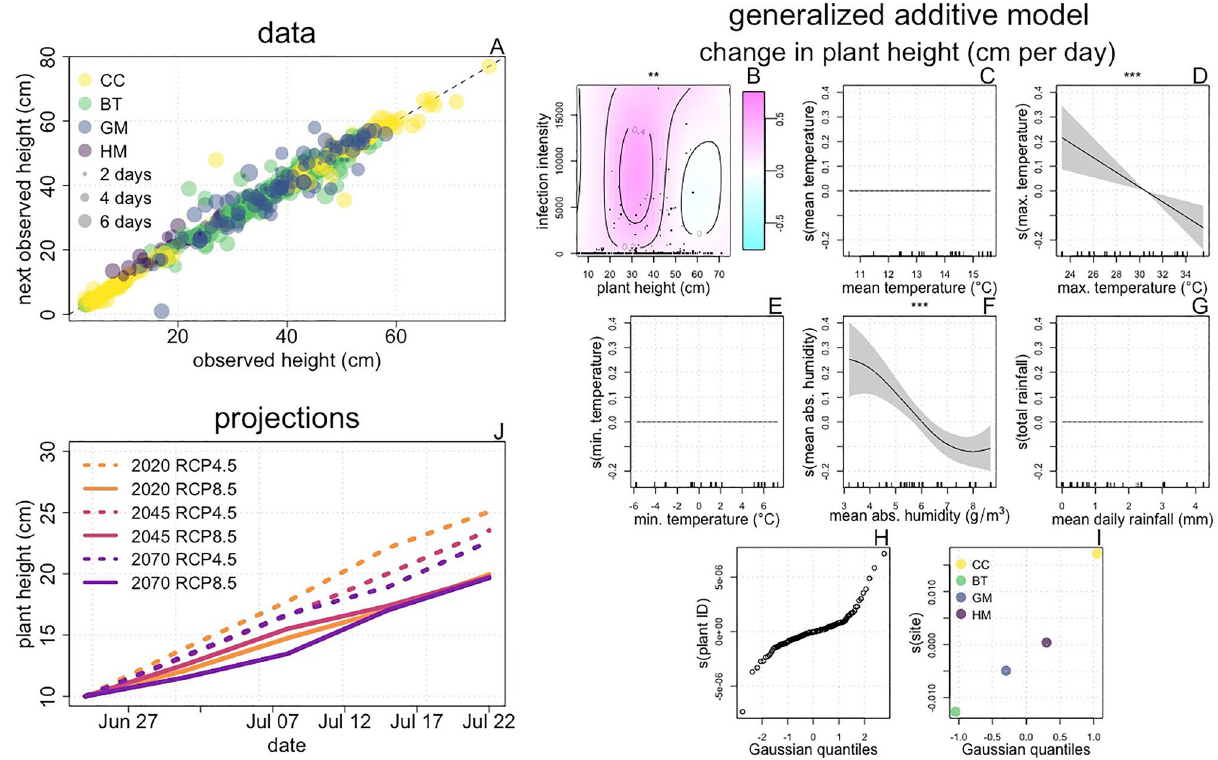
Figure 4. The joint effects of climate change and infection on L. lewisii growth. Data: We made a total of 596 observations of plant height from 175 focal plants (panel A ). Points show individual observations with color indicating site and size indicating elapsed time. Unsurprisingly, we observed both increases and decreases in plant height as plant condition changed over the course of the observation period. The dashed line illustrates y = x to show where increases and decreases occurred. Generalized additive model: We fit a GAM to this data, using change in plant height per day as the response variable, and smooth terms for weather variables as predictors along with a full tensor product of height and infection intensity. Plant identity and site were included as random effect smooths. Panel ( B ) shows the fitted tensor, with contours, shading, and points as in Fig. 3B. Panels ( C – G ) show fitted smooth terms with axes, lines, and shading as in Fig. 2B–G. Panels ( H ) and ( I ) show fitted random effects with points and axes as in Fig. 2H–I. Symbols above plots show the significance of smooth terms, with *** indicating p < 0.001, ** indicating p < 0.01, and * indicating p < 0.05. Projections: We simulated 100 growth trajectories for a small plant (starting with a height of 10 cm) at each site for six future weather data sets using the fitted GAM. The lines in panel ( J ) show means of the trajectories simulated for the GM site. Qualitatively similar patterns were observed in simulations performed for other sites (Supplementary Fig.